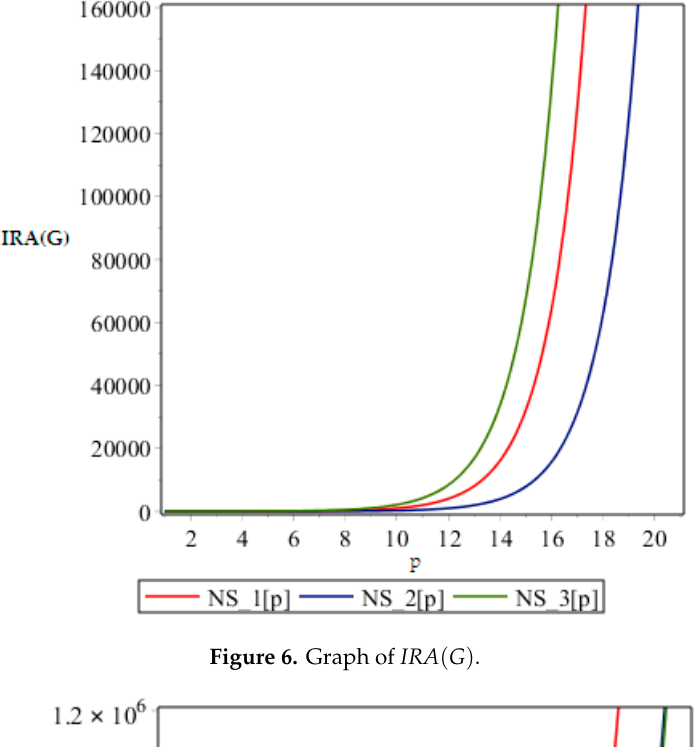
Figure 6. Graph of 𝐼𝑅𝐴(𝐺) . Figure 6. Graph of IRA ( G ) .